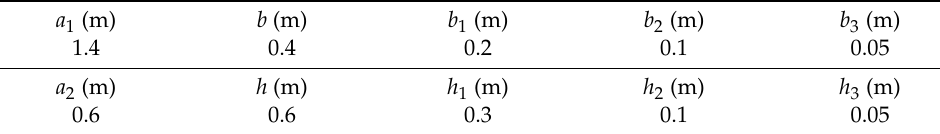
Table 2. Geometric